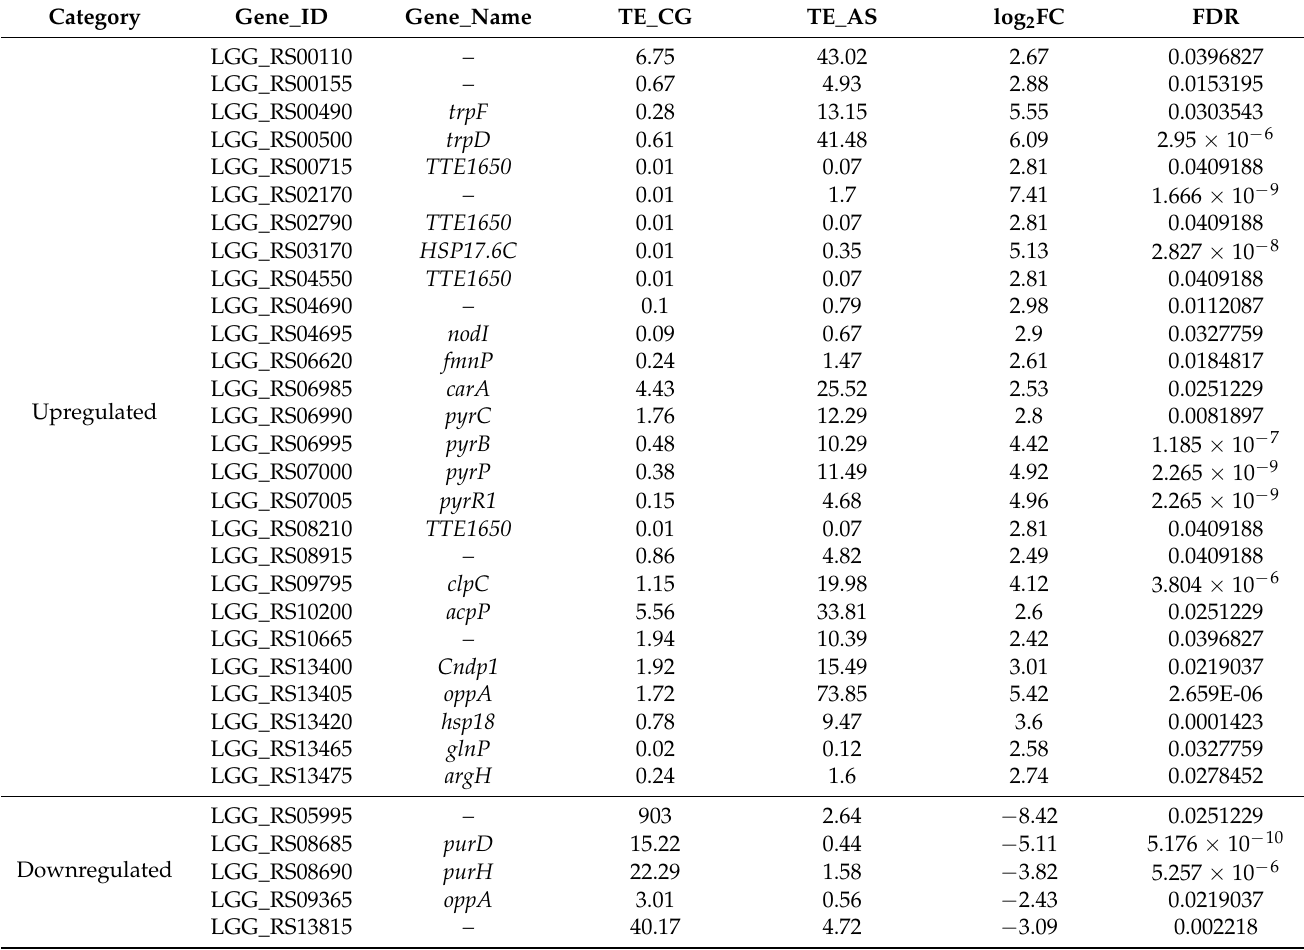
Table 1. Genes with differential translational efficiency regulation under acid